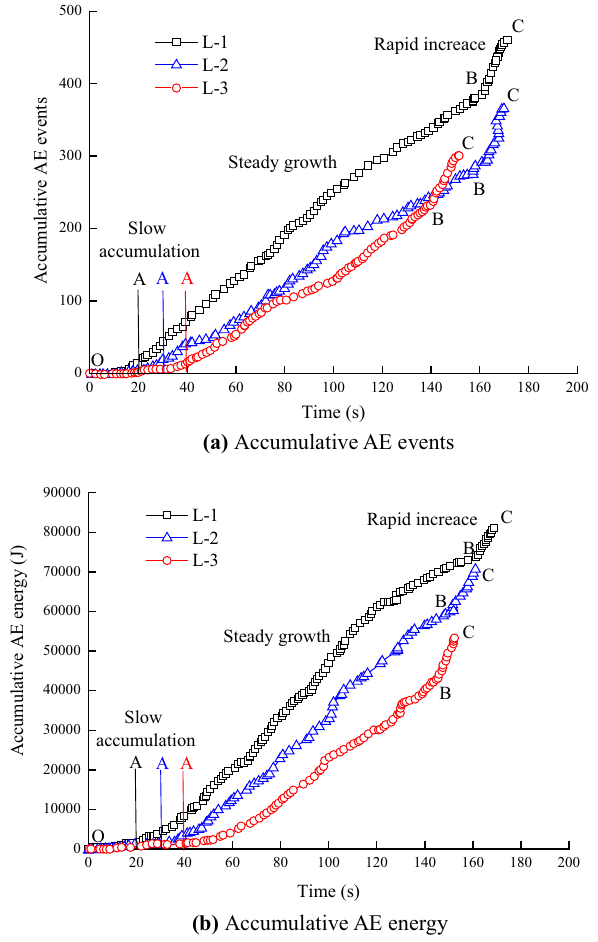
Fig. 12 AE activities for specimen L-1 to